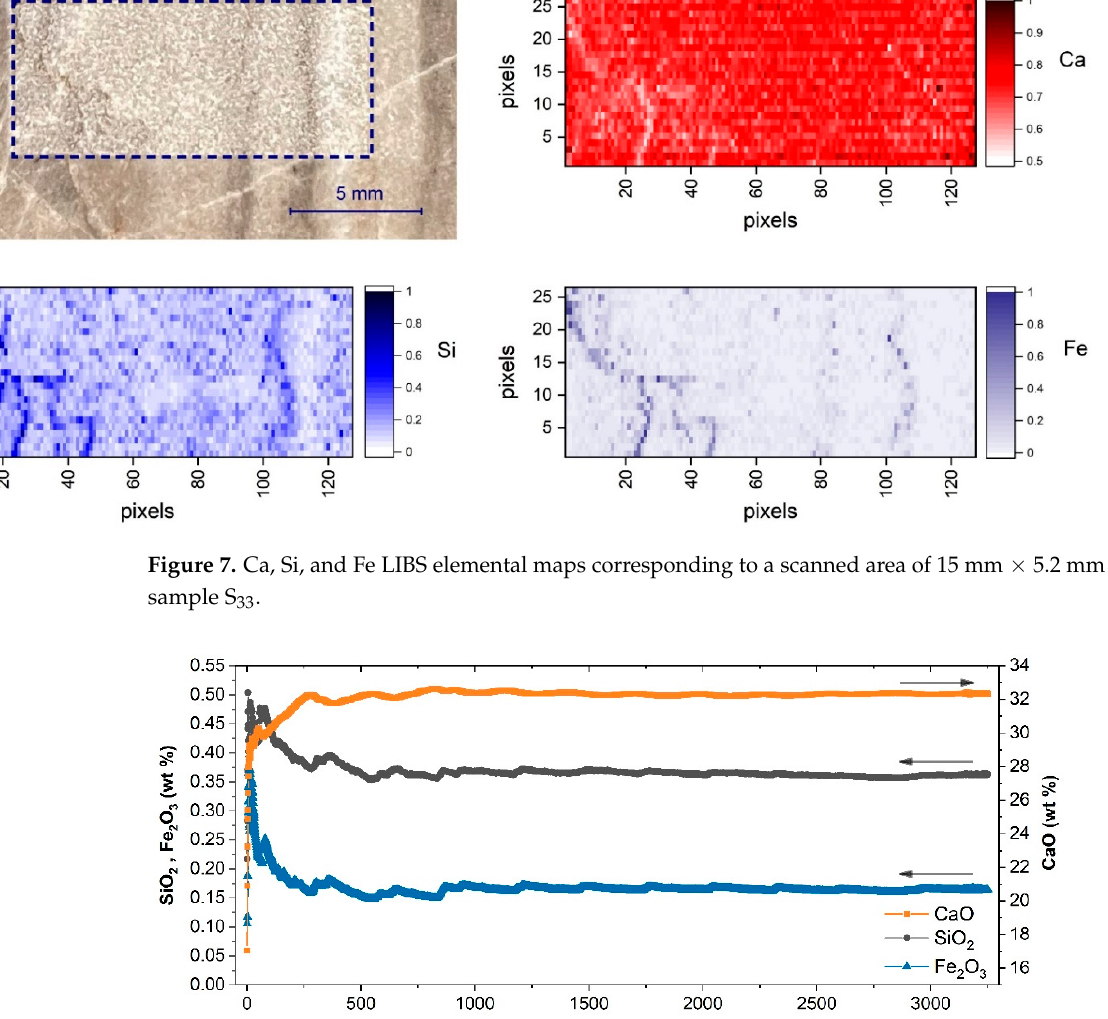
Figure 7. Ca, Si, and Fe LIBS elemental maps corresponding to a scanned area of 15 mm × 5.2 mm of sample S 33 .